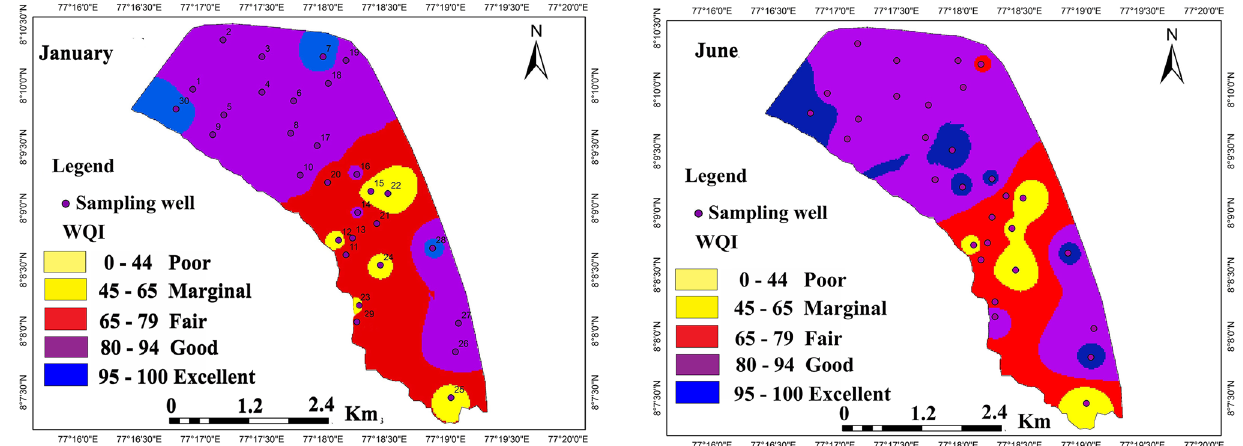
Fig. 6 Spatial distribution of WQI in the study area